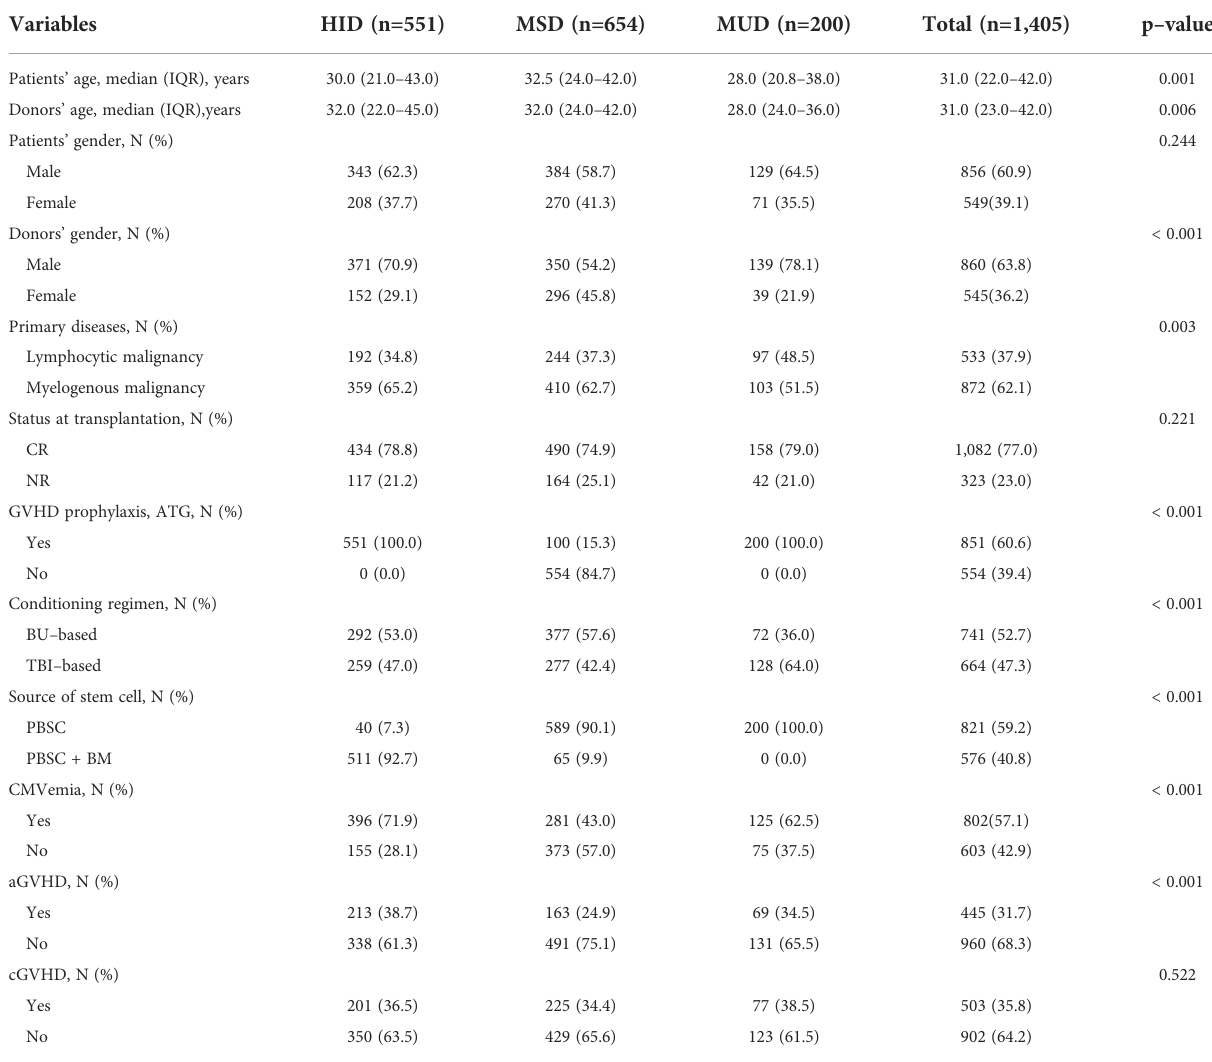
TABLE 1 Patients ’ clinical and transplant